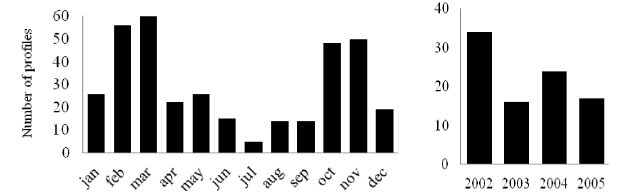
Fig. 5. Dataset histogram over the period 2002–2005.